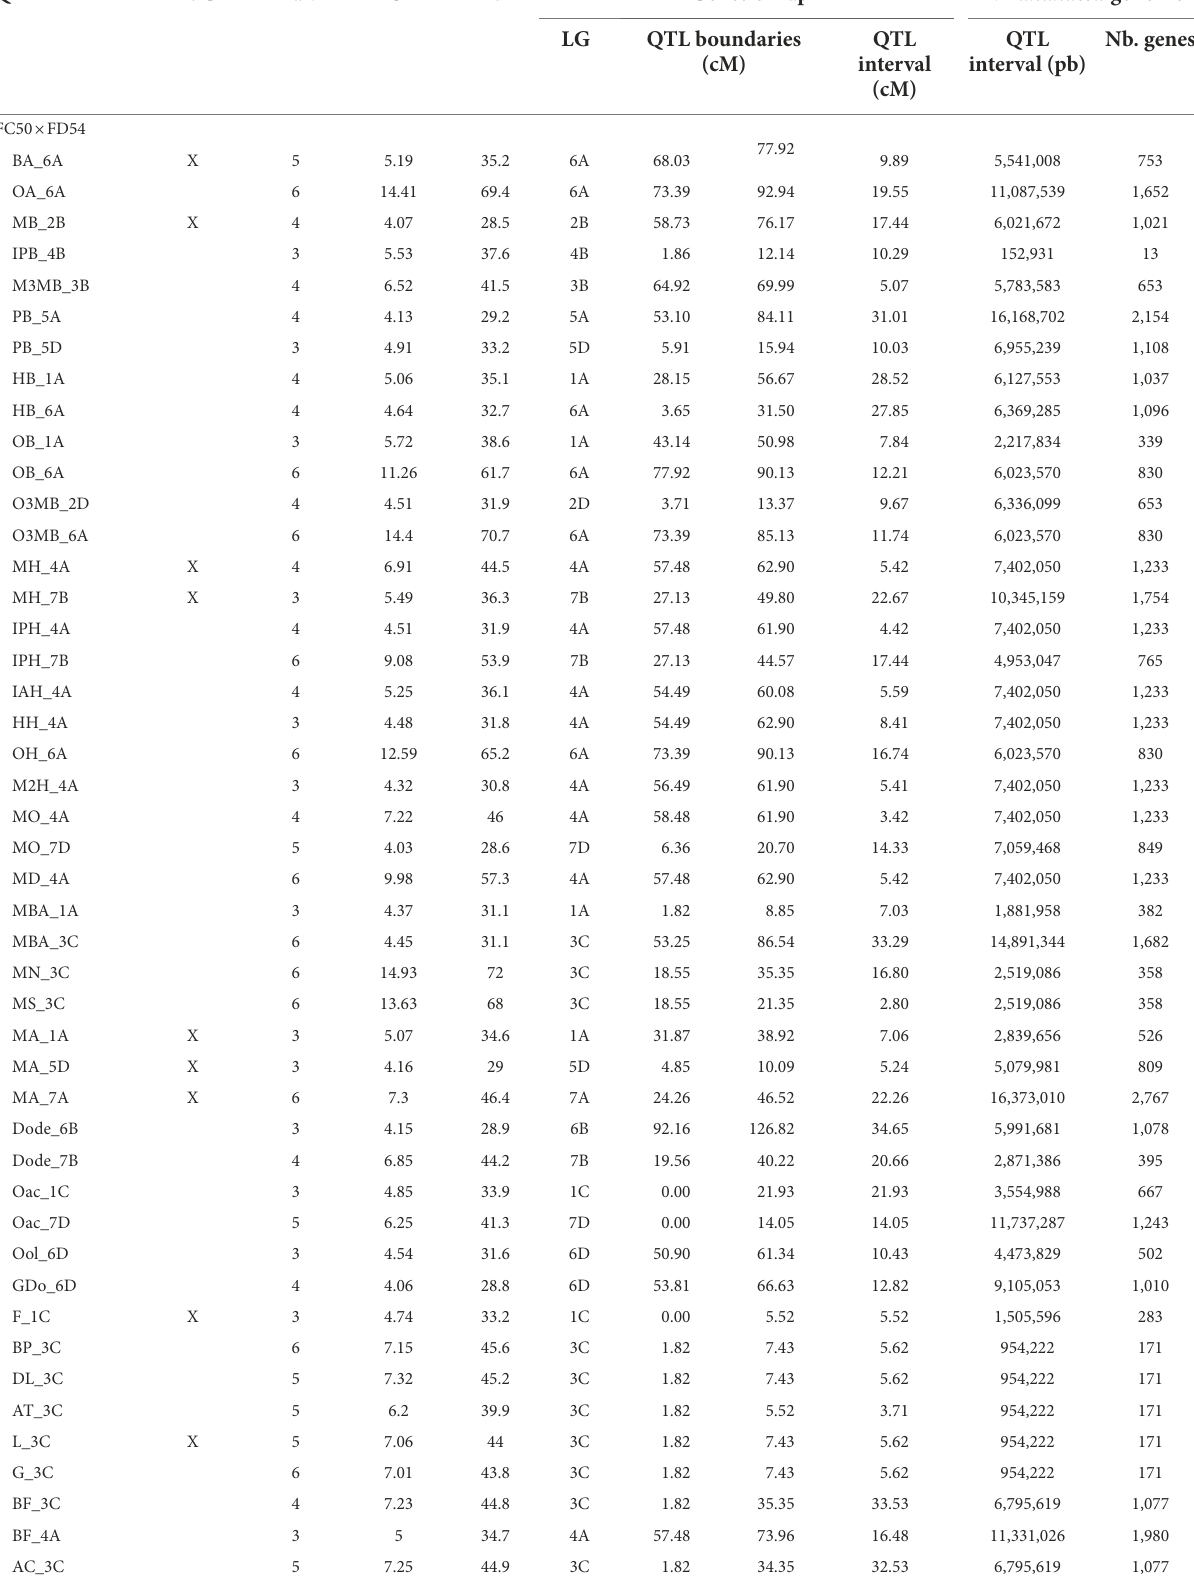
TABLE 2 VOC_QTLs detected in “FC50 × FD54” and “21AF” population. QTL ID KVC Har. LOD R 2 Genetic map F. × ananassa genome